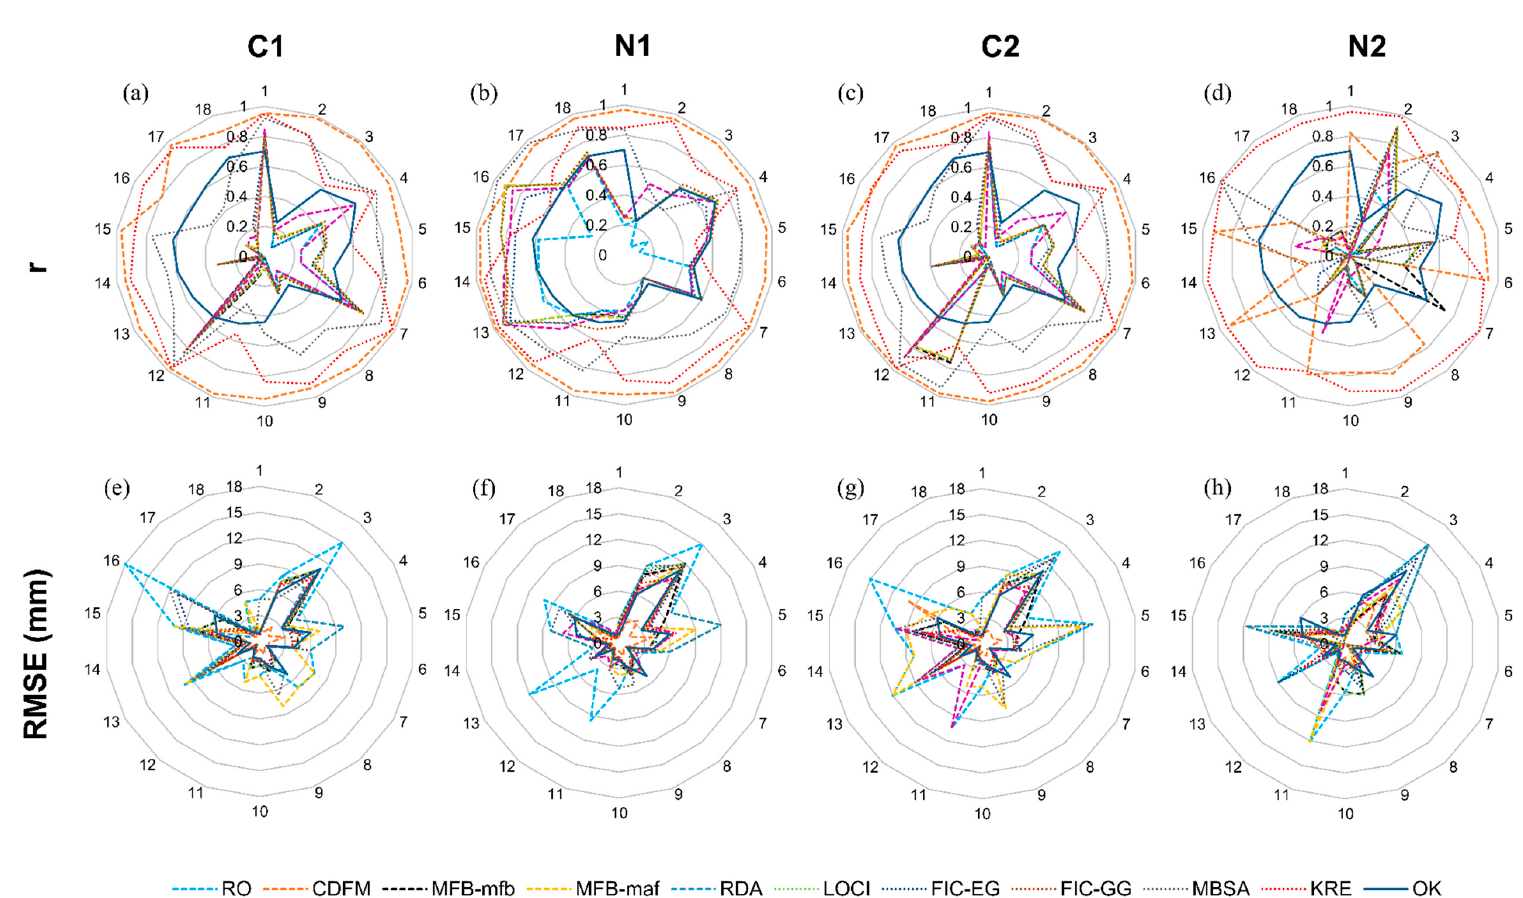
Figure 6. Average correlation ( a – d ) and RMSE ( e – h ) between the hourly accumulation of merged radar QPEs and gauge measurements for each event. Note: Summer events: 1, 3, 4, 5, 9, 10, and 13-17; Spring events: 2, 7, and 8; Fall events: 6, 11, 12, and 18.